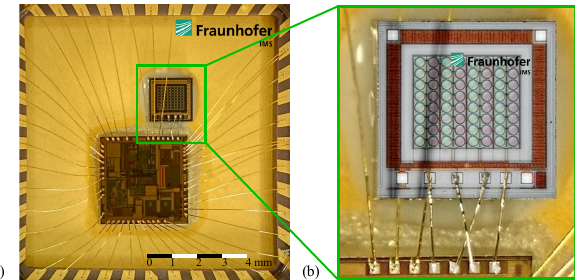
Figure 13. (a) Sensor system comprising the analog capacitive pressure sensor with sensing element diameters of about 92µm and the C/V converting readout circuit, both mounted in a CLCC44 package. (b) Magnification of the pressure